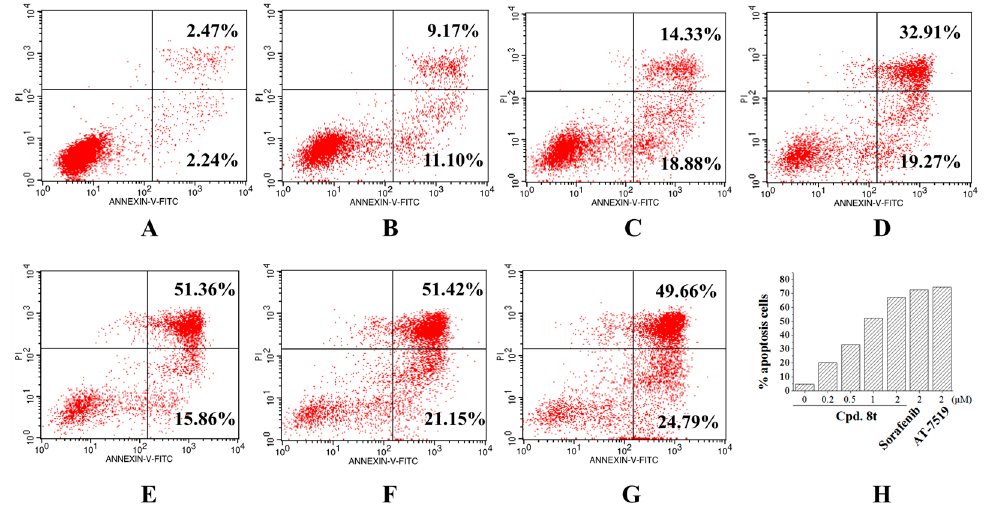
Figure 4. MV4-11 cells were treated with compound 8t for 24 h and then analyzed by AnnexinV/PI staining. The percentage of cells undergoing apoptosis was defined as the sum of early apoptosis, advanced apoptosis and necrotic cells. ( A ) DMSO control; ( B ) compound 8t at 0.2 µ M; ( C ) compound 8t at 0.5 µ M; ( D ) compound 8t at 1 µ M; ( E ) compound 8t at 2 µ M; ( F ) Sorafenib at 2 µ M; ( G ) AT-7519 at 2 μ M; ( H ) Quantification of apoptotic cells.